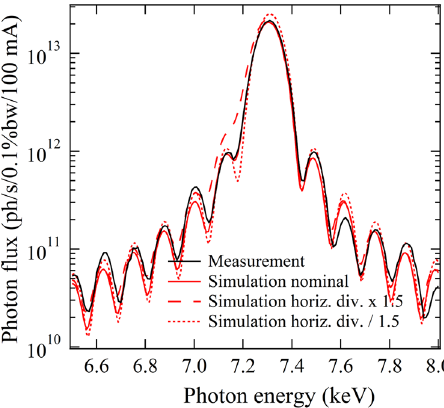
Fig. 5 Photon fl ux at beamline ID10. The curves are for fl ux from a single 1.6 m long, 27 mm period undulator measured with a 0.15 × 0.15 mm 2 slit at 27.2 m from the source (Measurement: black line). The undulator de fl ection parameter was set to 1.2, corresponding to the peak brilliance. For the simulations, the rms electron beam size was kept fi xed while the electron beam divergence was set to ±50% of the nominal value (red full line, red dotted (Horizontal divergence/1.5) and red dashed (Horizontal divergence × 1.5) lines).